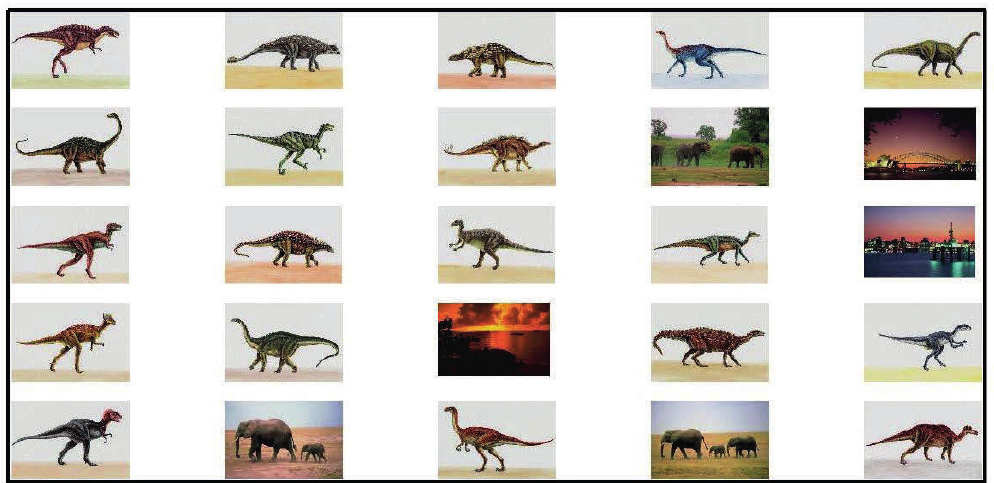
Fig. 14. Dinosaur images retrieved at the first stage of Framework-1 (EHD-KM).